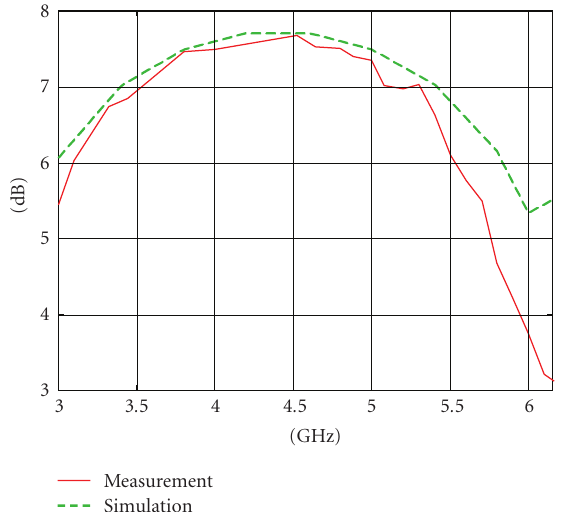
Figure 5: Comparison between simulated and measured gain in the main lobe direction over the bandwidth.